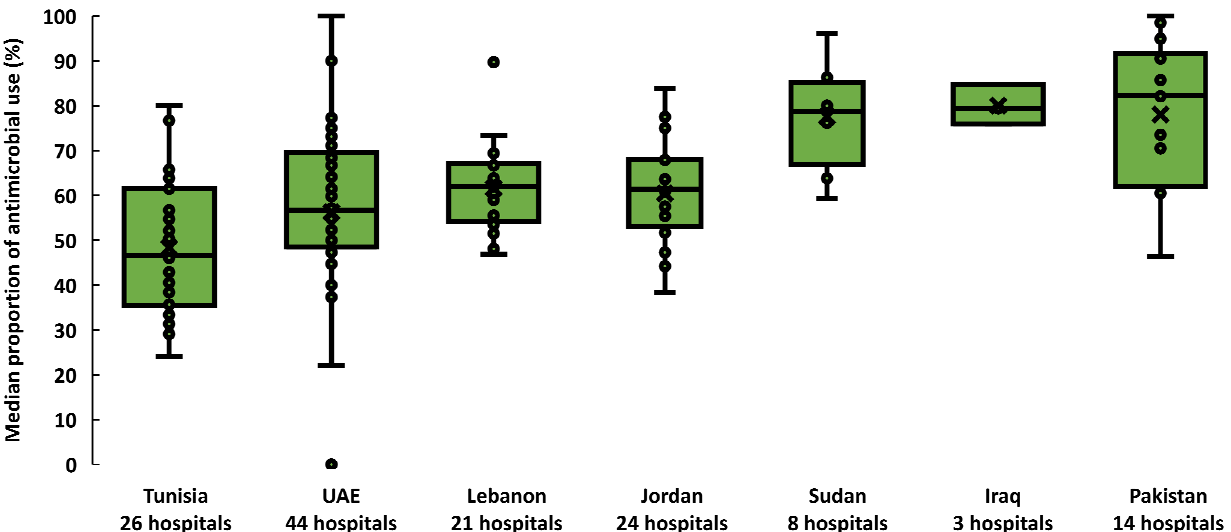
Figure 1. Prevalence of antimicrobial use across 139 hospitals, seven countries in the Eastern Mediterranean Region, 2019. Each dot represents the proportion of patients who received at least one antimicrobial in a hospital. Horizontal lines within boxes indicate medians, box tops and bottoms indicate interquartile ranges (middle 50% of data), and error bars (upper and lower whiskers) represent scores outside the middle 50%. UAE is the United Arab Emirates.